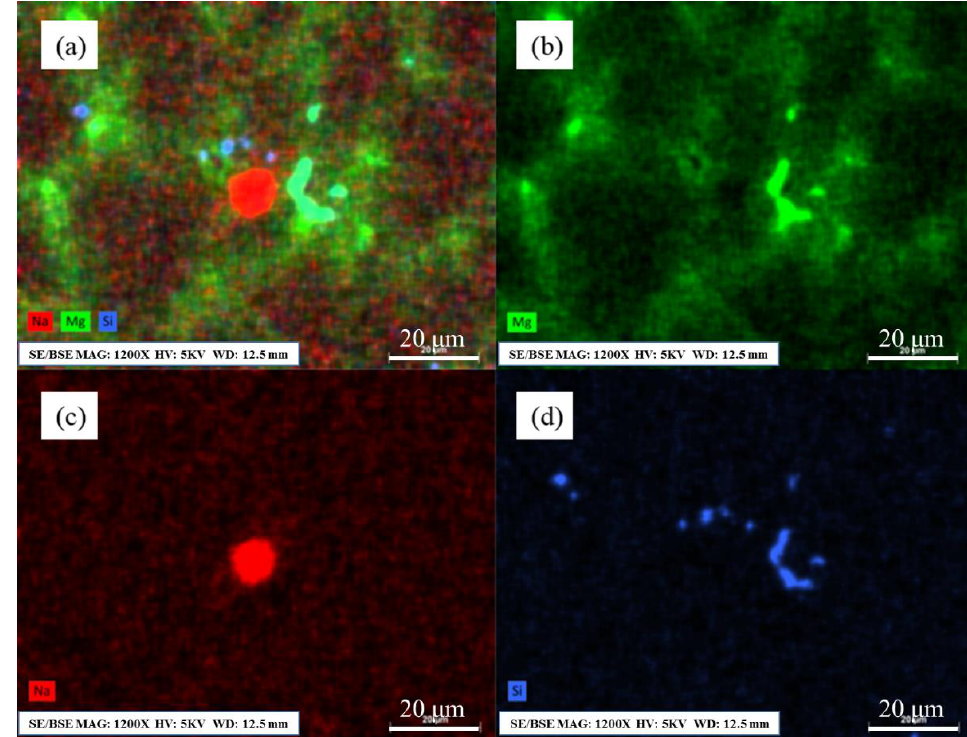
Figure 5. Elemental distribution of Na, Mg and Si in as-cast Al – 5Mg alloy ( a ) Na, Mg and Si; ( b ) Mg; ( c ) Na; ( d ) Si.